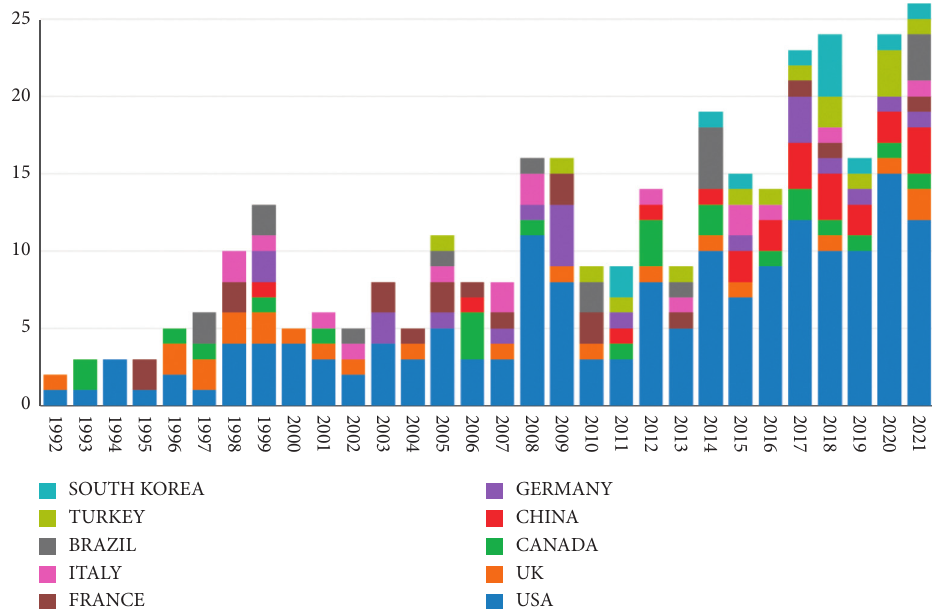
Figure 2: The distribution of the bibliographic records per year of the top 10 countries on analgesics in the treatment of orthopedic postoperative